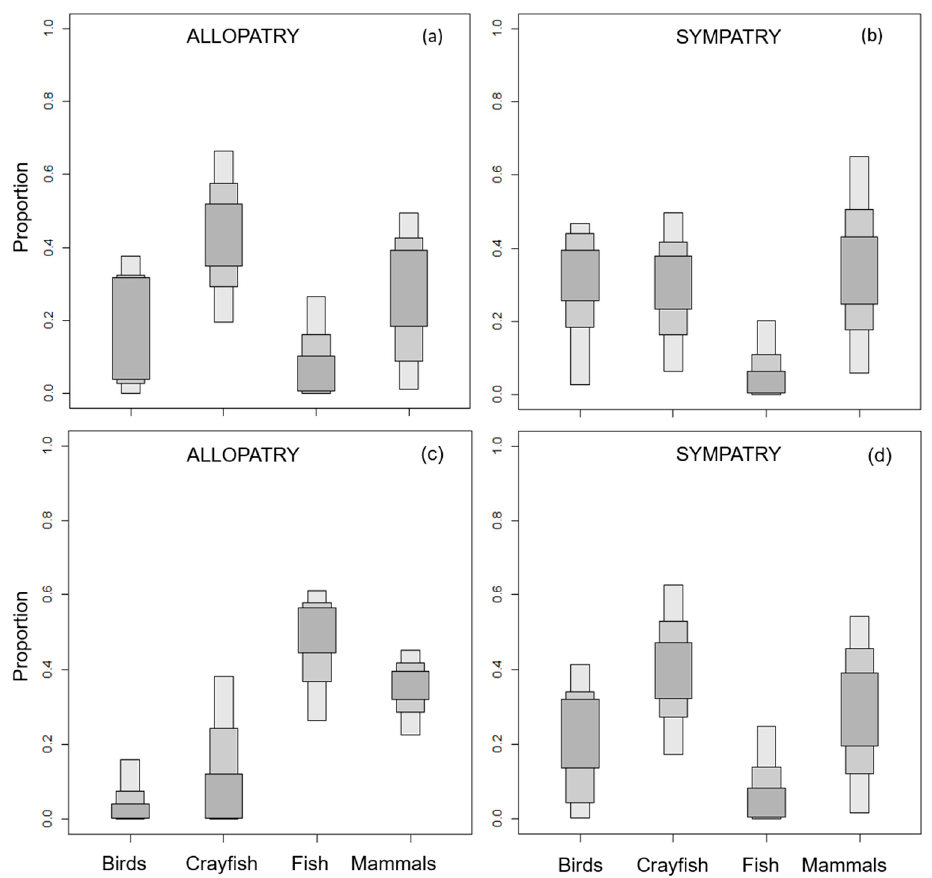
Figure 3. Diet compositions of the European mink in ( a ) allopatry and ( b ) sympatry, and of the American mink in ( c ) allopatry and ( d ) sympatry according to the SIAR mixing model, using the indirect vibrissae discrimination factor. The contribution of each prey to the diet is shown with 95% (light grey), 75% (medium grey), and 50% (dark grey) credibility intervals. Bayesian estimates of TP supported the mixing model results, with a decrease in the consumption of prey of a higher trophic level in sympatric compared with allopatric populations. The mean (95% credibility intervals) estimated TP for the EM allopatric samples was 3.5 (2.1–4.3), while for sympatry the estimated TP decreased to 3.2 (2.0–4.0) (Table 1, Figure 4a). Table 1. The mean (±SD) δ 13 C and δ 15 N values of each mink species and their primary carbon sources. n = number of samples; TP = trophic position (95% credibility intervals); TA = Total area; SEAc = standard ellipse area corrected for a small sample size, representing the isotopic niche metrics calculated for both mink species in sympatry based on the δ 13 C and δ 15 N values.